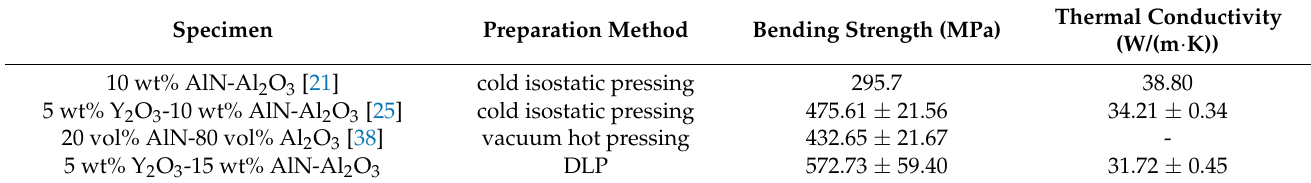
Table 4. The thermal conductivity of Al 2 O 3 -AlN ceramics prepared by DLP is close to that of other preparation methods, but the bending strength is improved. Table 4. Bending strength and thermal conductivity of Al 2 O 3 -AlN ceramics fabricated by different methods.